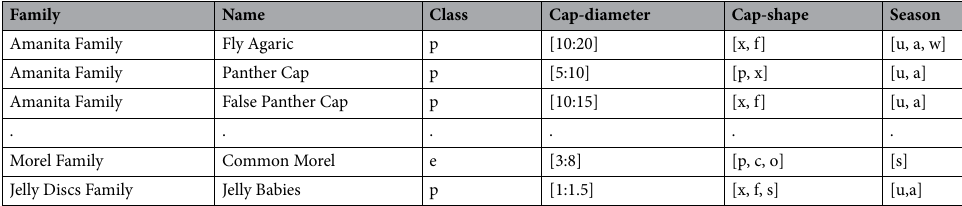
Table 1. Primary data excerpt. The square brackets refer either to a set of nominal variables or to a continuous range of values. The single letters were encoded as nominal variables. Regarding continuous variables (seen as float numbers), they correspond to lengths in centimeters (cm), with the exception of stem-width reported in millimeter (mm). The shown columns are the three classes, the first two variables and the last variable. Intermediary columns are not shown due to page and column size